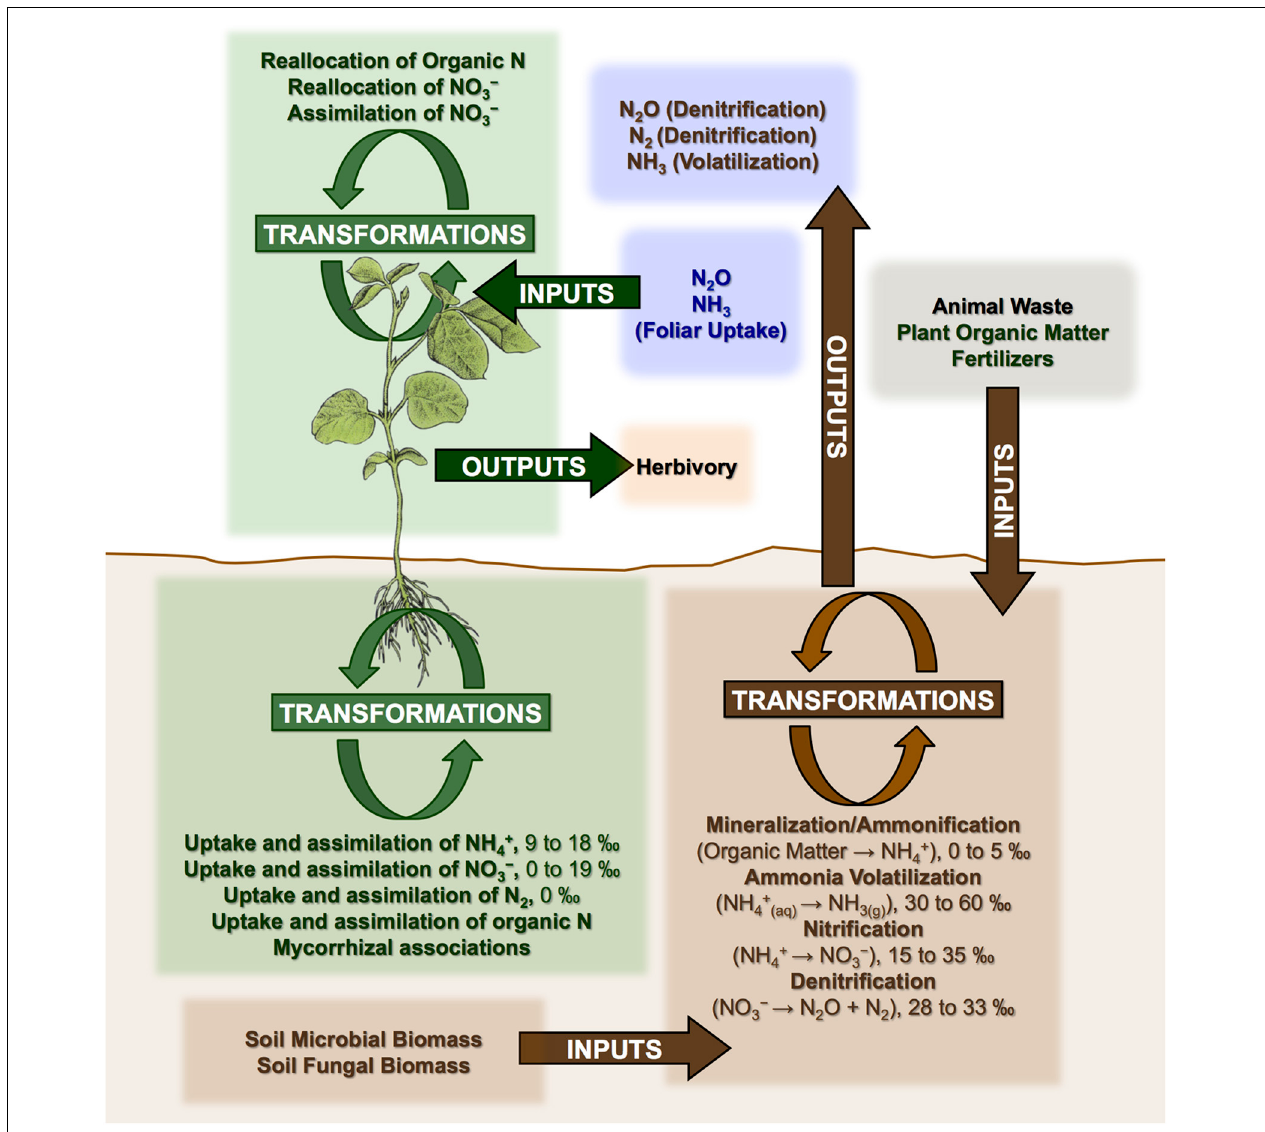
FIGURE 3 | Generalized model of N cycling in plant-soil systems showing processes that may affect plant N isotopic compositions. Mineralization refers to the conversion of organic N into ammonium (NH + 4 ). Nitrification refers to the conversion of ammonium into nitrate (NO − 3 ).